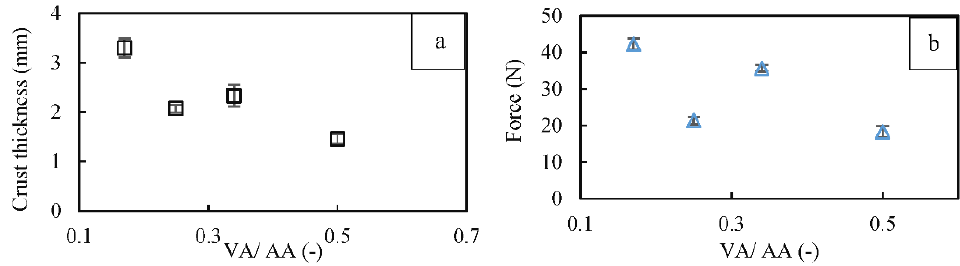
Figure 7. Variations in ( a ) crust thickness and ( b ) penetration failure force for FS30-treated samples with different VA/AA ratios.